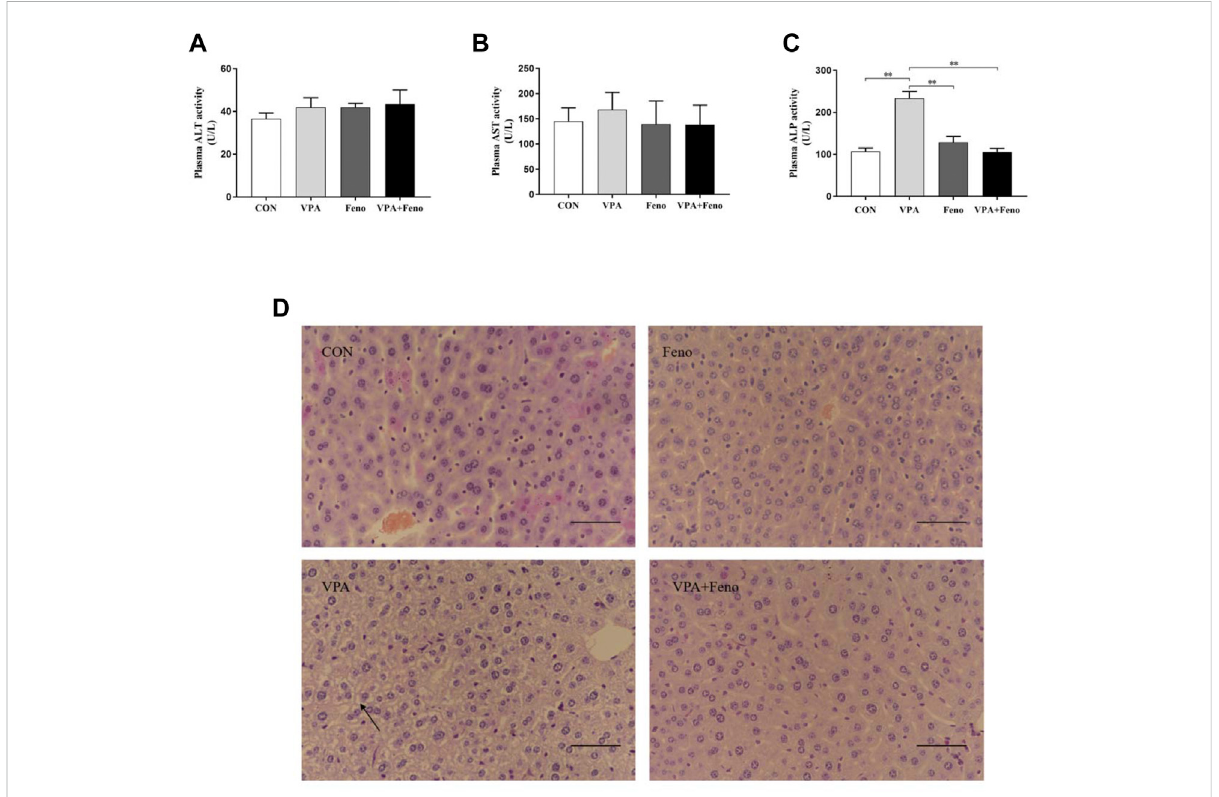
FIGURE 8 Effect of Feno on liver tissue morphology and biochemical indexes of liver function in VPA-induced hepatotoxic mice. (A – C) Changes of Feno on biochemical indexes of plasma liver function in mice (D) H and E staining to observe the effect of Feno on liver tissue structure in mice (scale bar, 50 μ m); black arrow: microvesicular steatosis. Data are expressed as mean ± SD ( n = 6). *p < 0.05, **p < 0.01; CON: control group; VPA: VPA 500 mg/kg group; Feno: Feno50 mg/kg group; VPA + Feno: VPA 500 mg/kg + Feno50 mg/kg group; ALP, alkaline phosphatase; ALT, alanine aminotransferase; AST, aspartate